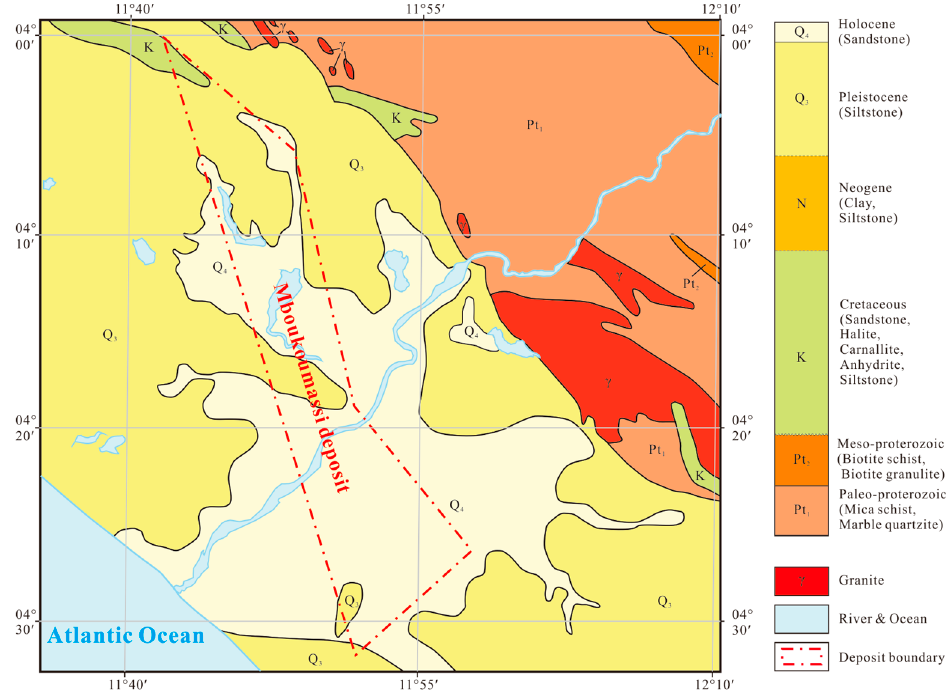
Figure 1. Geological map for Mboukoumassi deposit (Modified after Martiniand Bowles (1994) [10]).